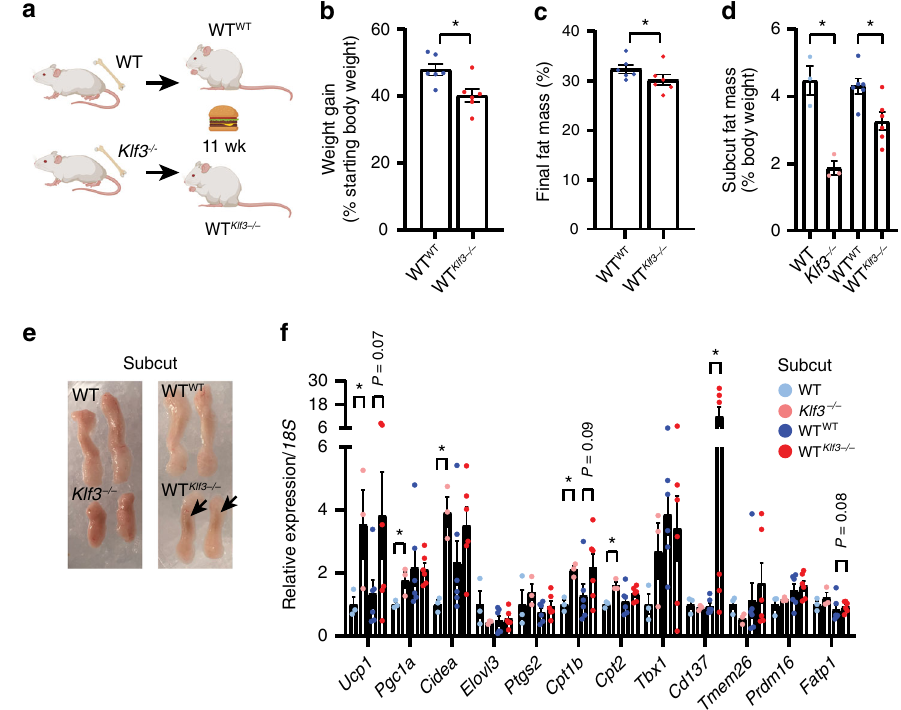
Fig. 3 Reduced weight gain in WT mice transplanted with Klf3 − / − BM. a WT mice were irradiated and transplanted with bone marrow from WT (WT WT ) or Klf3 − / − (WT Klf3 − / − ) donors then fed a high-fat, high-sugar (Western) diet for 11 weeks (wk) (cartoon created with BioRender.com). b Body weight was monitored throughout the Western diet study duration (weeks 2 – 13), and the total weight gained was calculated as a percentage of starting body weight at commencement of Western diet administration ( n = 6 mice). c Fat mass composition (%) was assessed using EchoMRI after 11 weeks of Western diet ( n = 6 mice). d Weights of subcut AT (relative to body weight) from WT, Klf3 − / − ( n = 3), WT WT and WT Klf3 − / − ( n = 6) mice fed a Western diet for 11 weeks. e Representative macroscopic images of subcut AT pads from mice of each condition, showing size and complexion. Arrows point to sites of enriched brown appearance. f mRNA levels of thermogenic genes in the subcut AT of WT, Klf3 − / − ( n = 3), WT WT and WT Klf3 − / − ( n = 6) mice were assessed by qPCR. Relative expression was normalised to levels of 18S rRNA and the mean WT value set to 1 for each target. For b – d and f , error bars represent means ± SEM and one-sided non-parametric Mann – Whitney U tests were performed where * P < 0.05. Source data are provided as a Source data fi le. See also Supplementary Figs. 4,